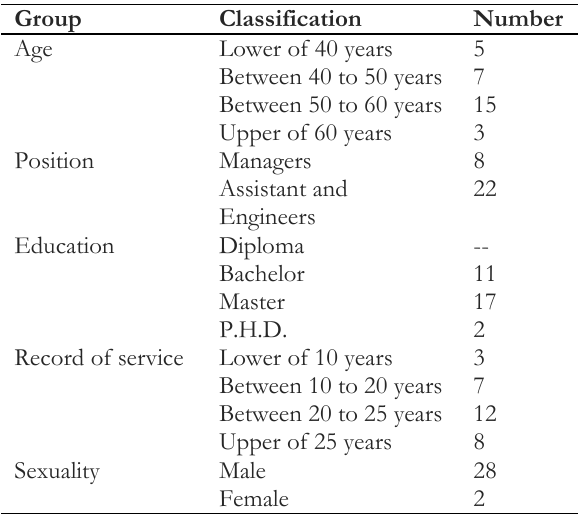
Table 6. Information of experts.